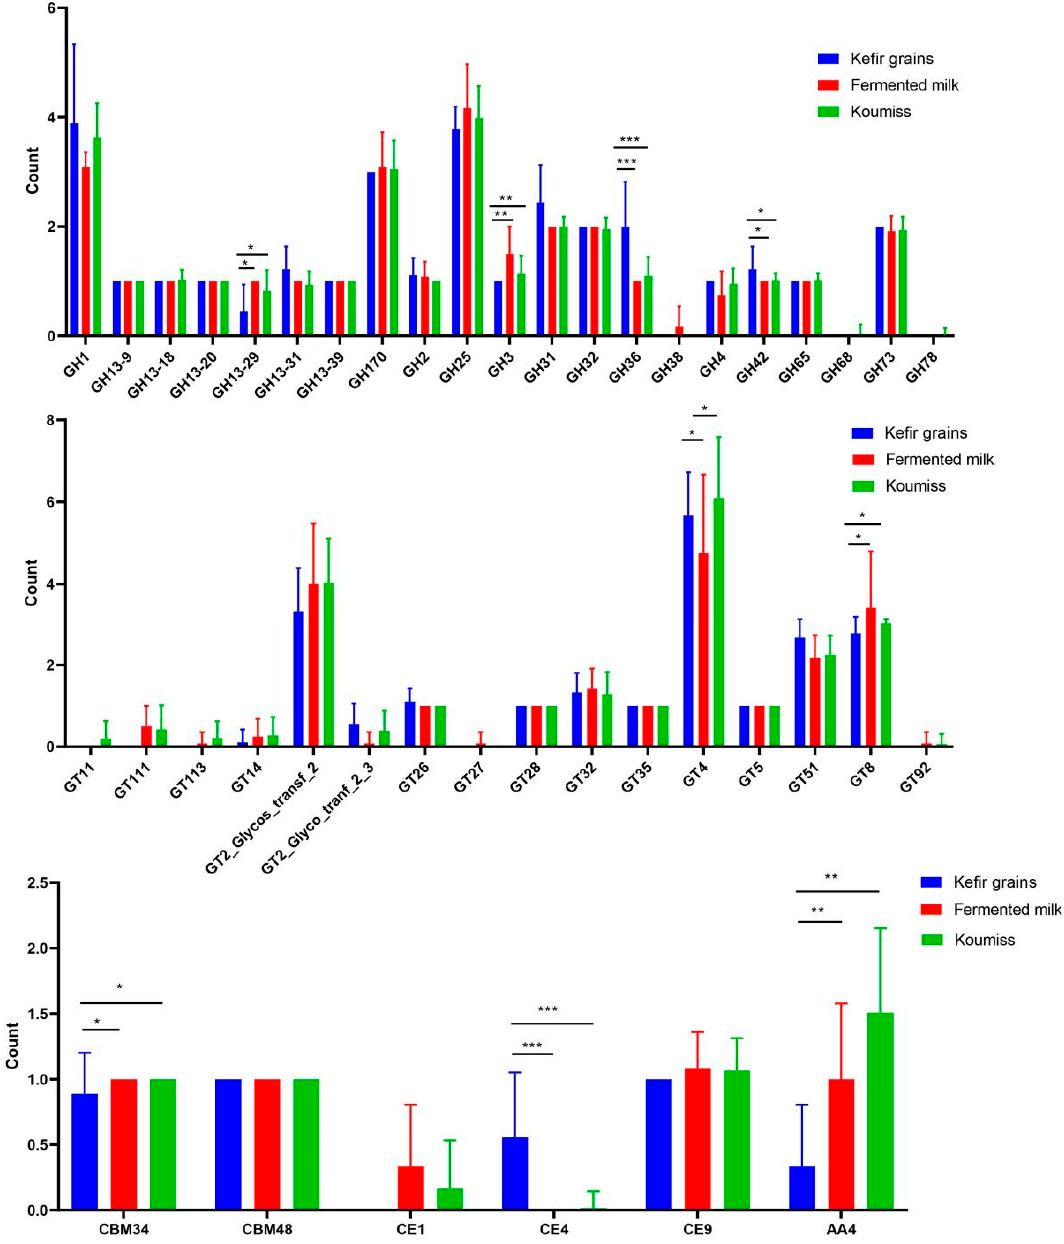
Figure 7. Di ff erences in CAZy in di ff erent L. ke fi ranofaciens strains isolated from di ff erent sources. *: Samples have a li tt le signi fi cant di ff erence. **: Samples have a large signi fi cant di ff erence. ***: Samples have a very large signi fi cant di ff